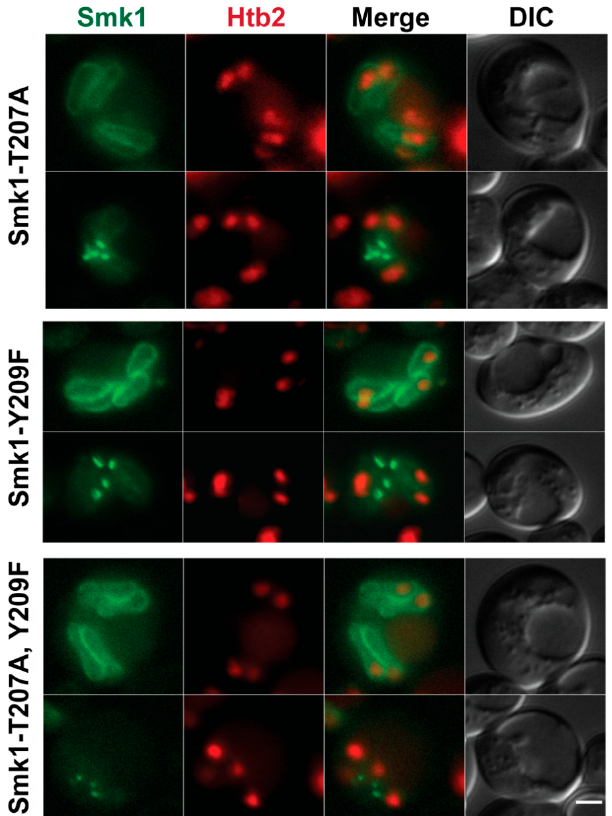
Figure 3. Smk1 localization is independent of its activation state. Localization of Smk1-T207A (LH1119), Smk1-Y209F (LH1120), and Smk1-T207A, Y209F (LH1121) to both elongated prospore membranes and the leading edge of the prospore membrane. smk1 activation site mutations are epitope tagged with GFP ENVY . Htb2-mCherry is used as a histone marker. Scale bar = 2 µM. 3.4. Localization of Smk1 Requires the LEP Member ADY3 , but Not IRC10 or DON1